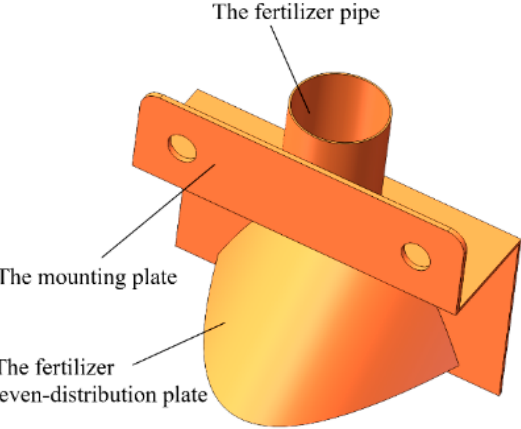
Figure 6. Schematic diagram of wide-boundary fertilization device.